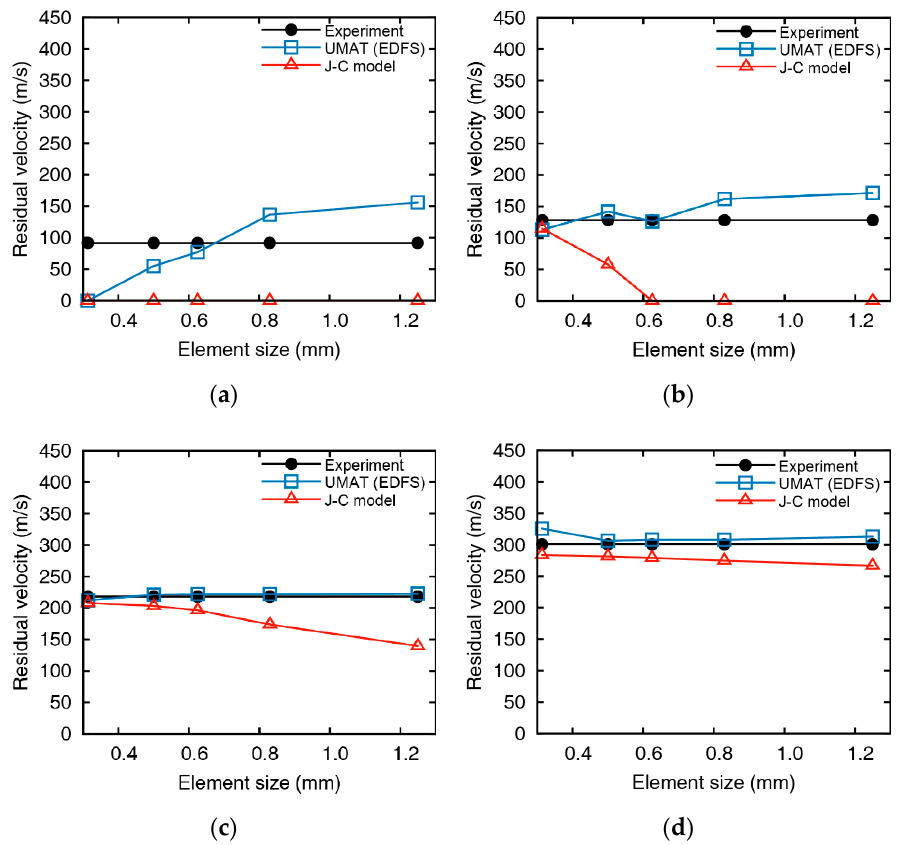
Figure 13. Comparison between impact test and numerical analysis at an initial velocity of ( a ) 200.9, ( b ) 215.5, ( c ) 264.9, and ( d ) 346.8 m / s ( t pl = 10 mm).